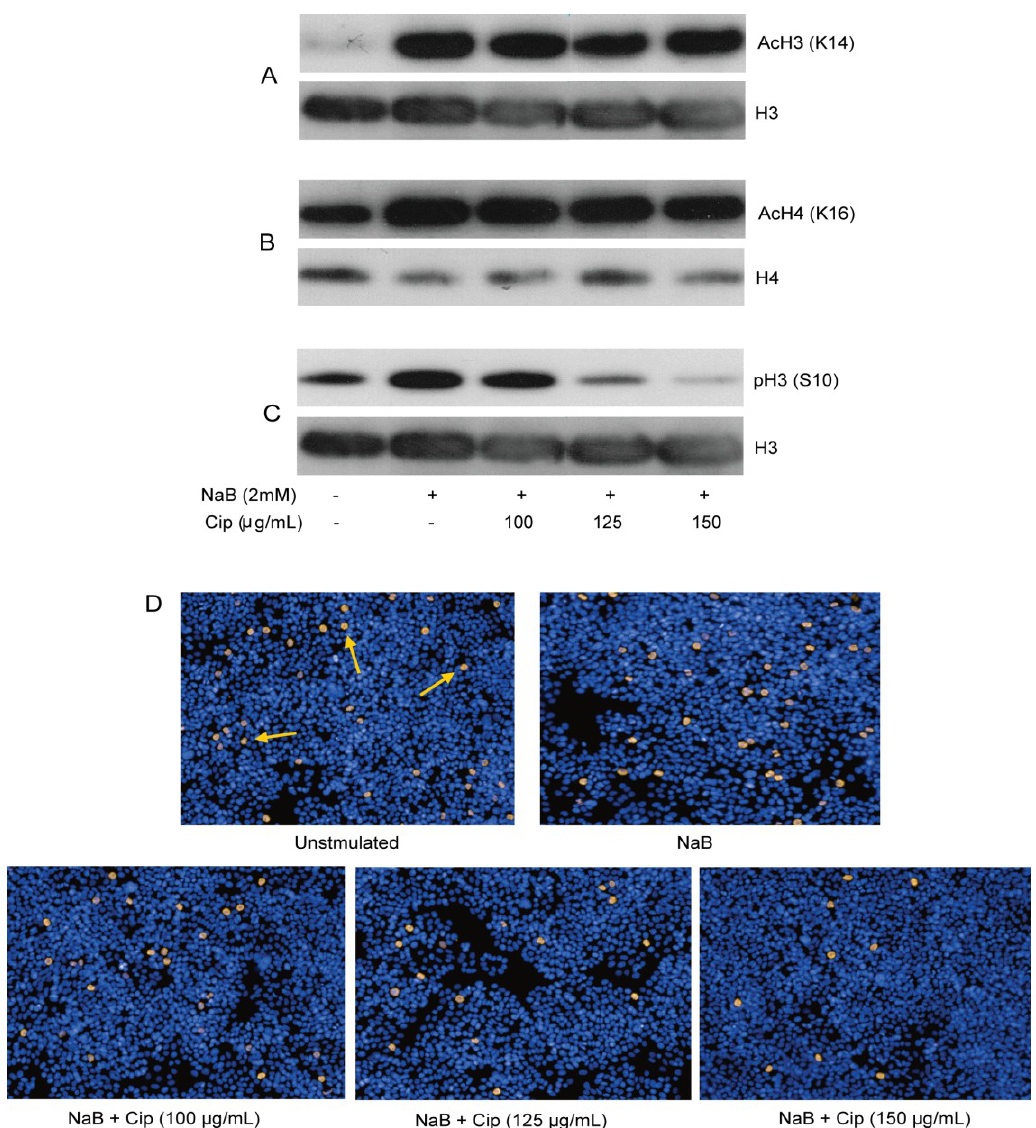
Figure 5. Histone modifications in HT-29 cells after treatment with NaB alone or in combination with ciprofloxacin. HT-29 cells were stimulated for 24 h with 2 mM NaB alone or in combination with different concentrations of ciprofloxacin. Histone was extracted from cells and utilized for Western blot analysis to detect ( A ) acetylation of histone H3 Lys14; ( B ) acetylation of histone H4 Lys16; ( C ) phosphorylation of histone H3 Ser10; ( D ) Phosphorylation of histone H3 at Ser10 was also detected by immunofluorescence staining of the cells. Arrows indicate examples of positively stained cells. NaB: sodium butyrate; Cip: ciprofloxacin; AcH3(K14): Acetylation of histone H3 at Lys14; AcH4(K16): Acetylation of histone H4 at Lys16; pH3(S10): Phosphorylation